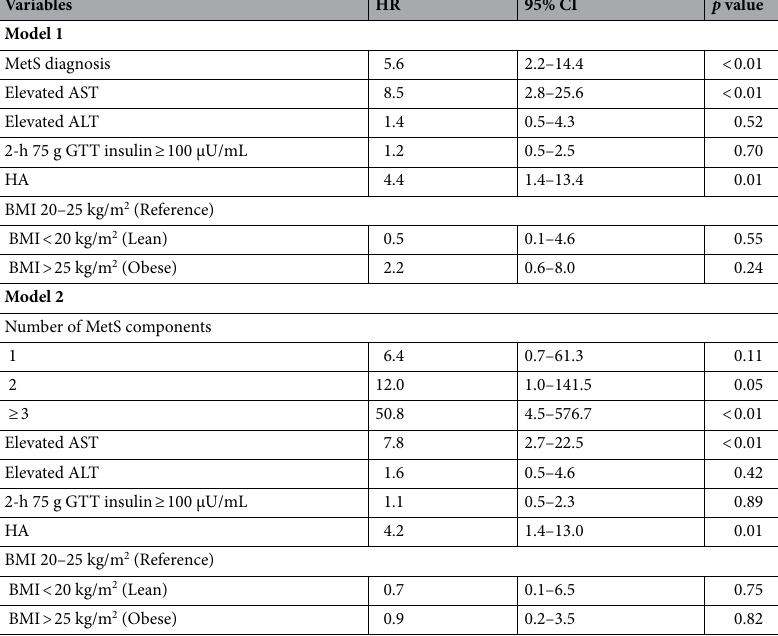
Table 4. Multivariate analysis of variables associated with NAFLD. (a) Model 1: according to MetS diagnosis. (b) Model 2: according to the number of MetS components. The categorical variables were MetS component (reference: none), number of MetS components (reference: number 0), Elevated AST (reference: normal AST level at PCOS diagnosis), Elevated ALT (reference: normal ALT level at PCOS diagnosis), 2-h 75 g GTT insulin